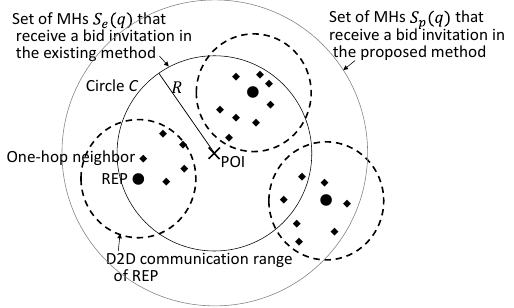
Figure 6. Example of a case where 𝑆 𝑝 (𝑞) ⊇ 𝑆 𝑒 (𝑞) .